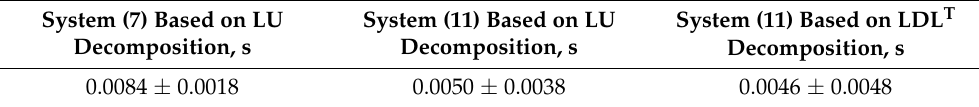
Table 3. The mean values of the normalized root mean square error of the parameter estimation and their standard